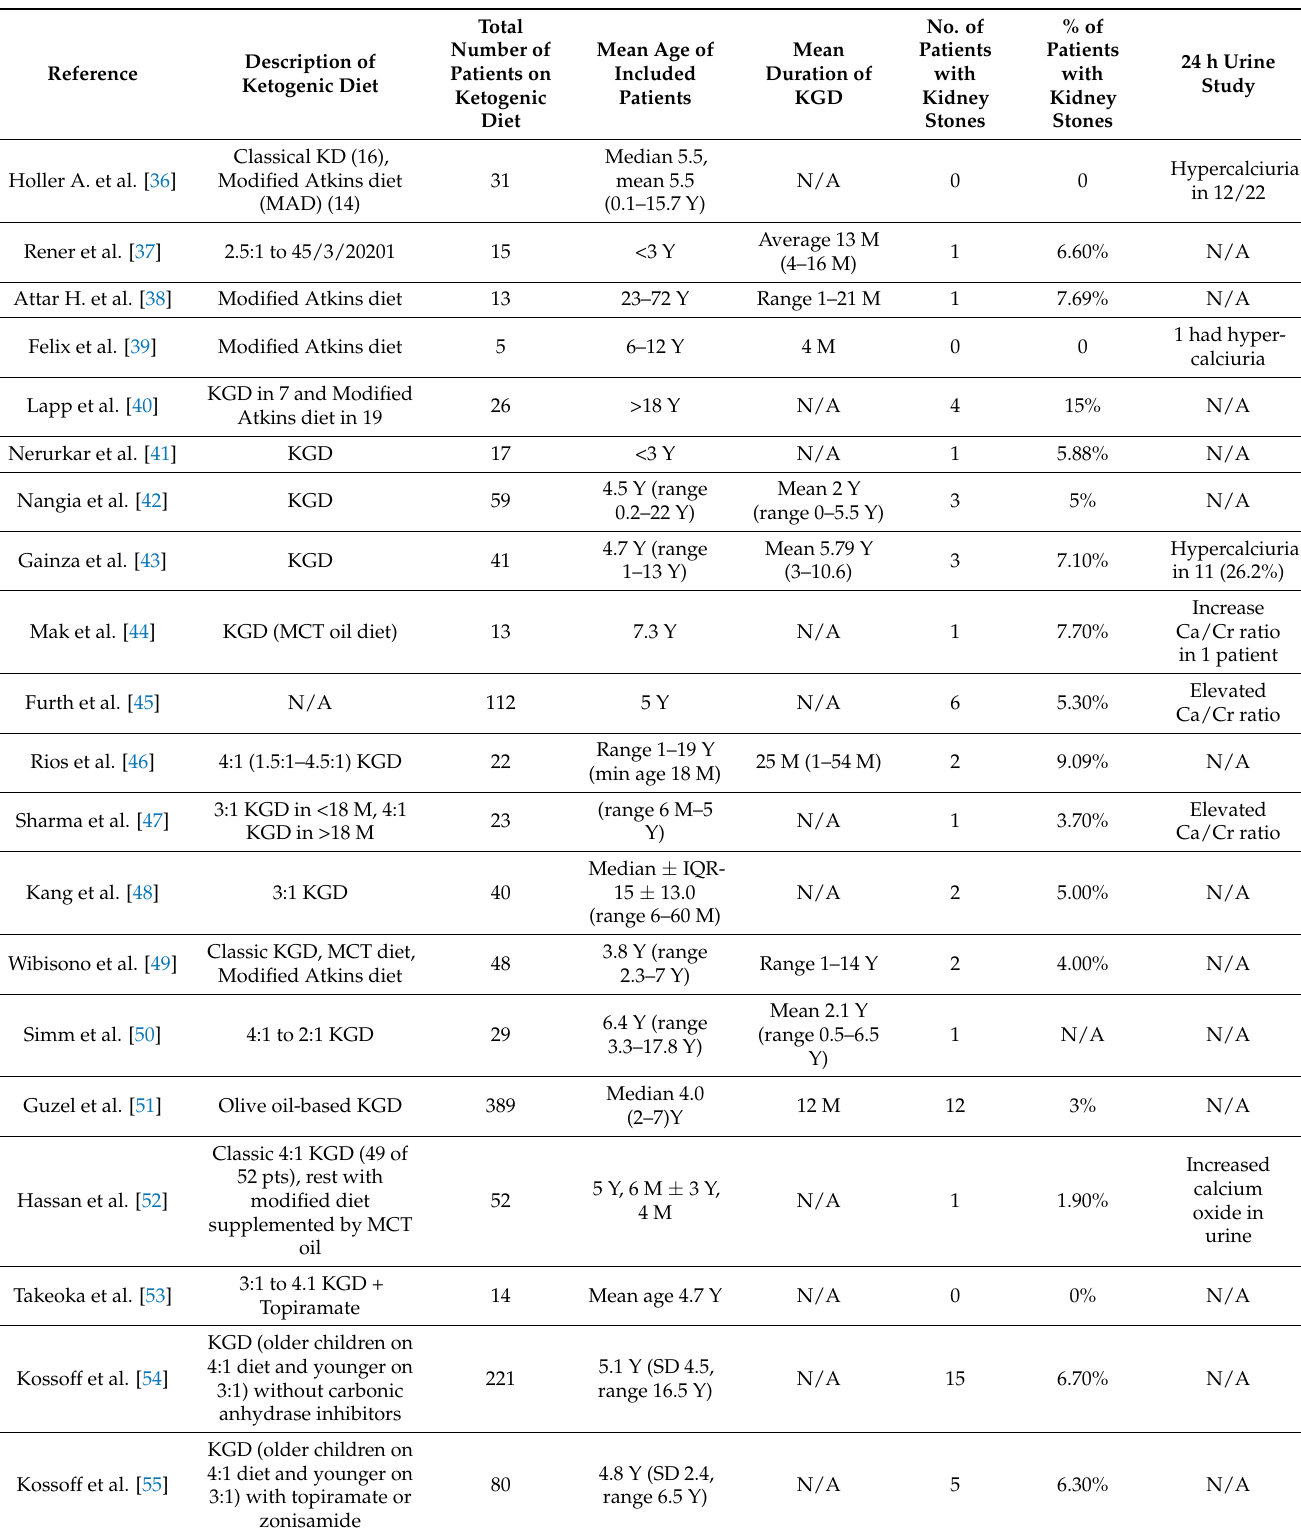
Table 1. Characteristics of studies included in this systematic